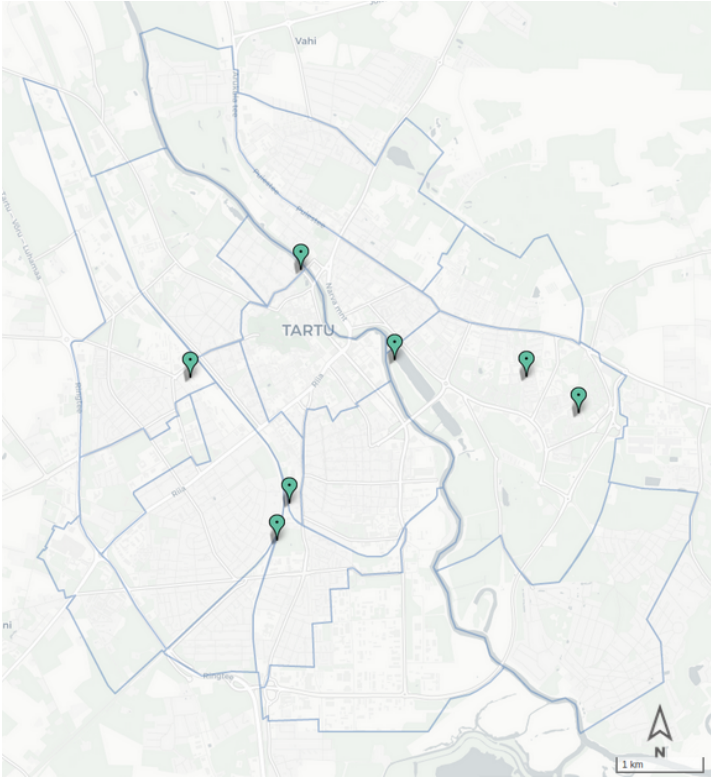
Figure 8. Locations of ECO sensors for pedestrian counts.